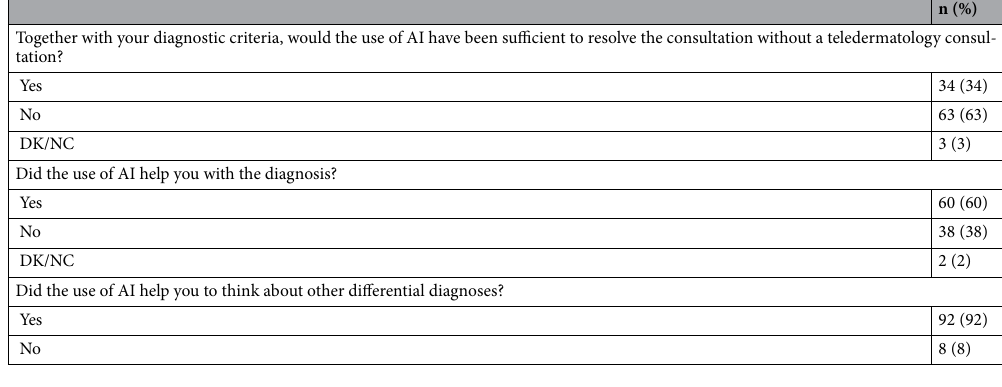
Table 5. Satisfaction and acceptance of the